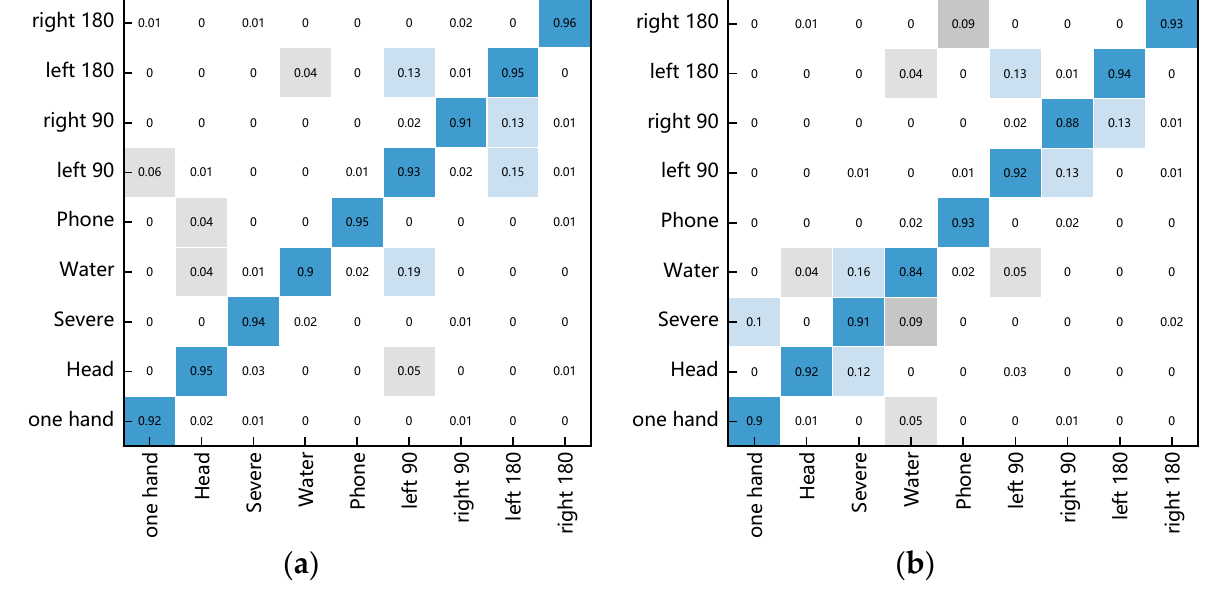
Figure 11. ( a ) Accuracy under GRU parameters; ( b ) accuracy under LSTM parameters.